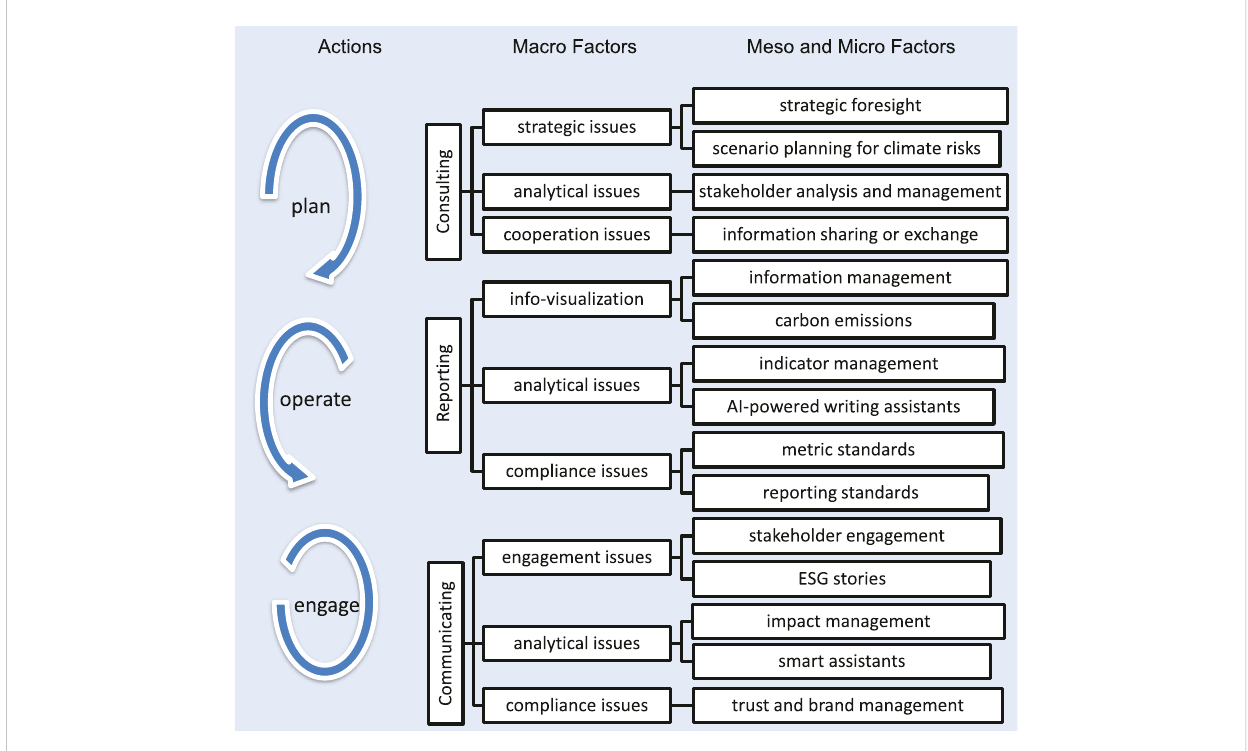
FIGURE 4 Smart system requirements of ESG and carbon information